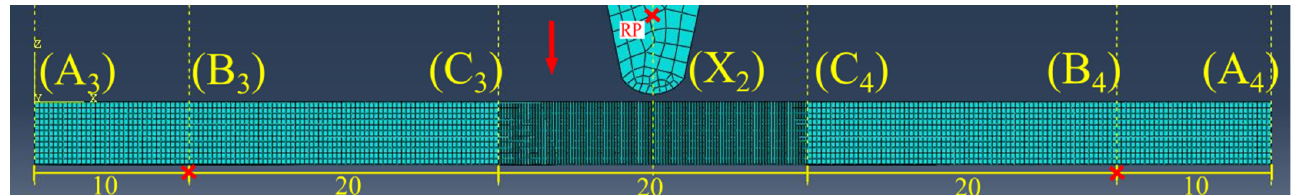
Table 2. Primary input parameters for numerical testing.